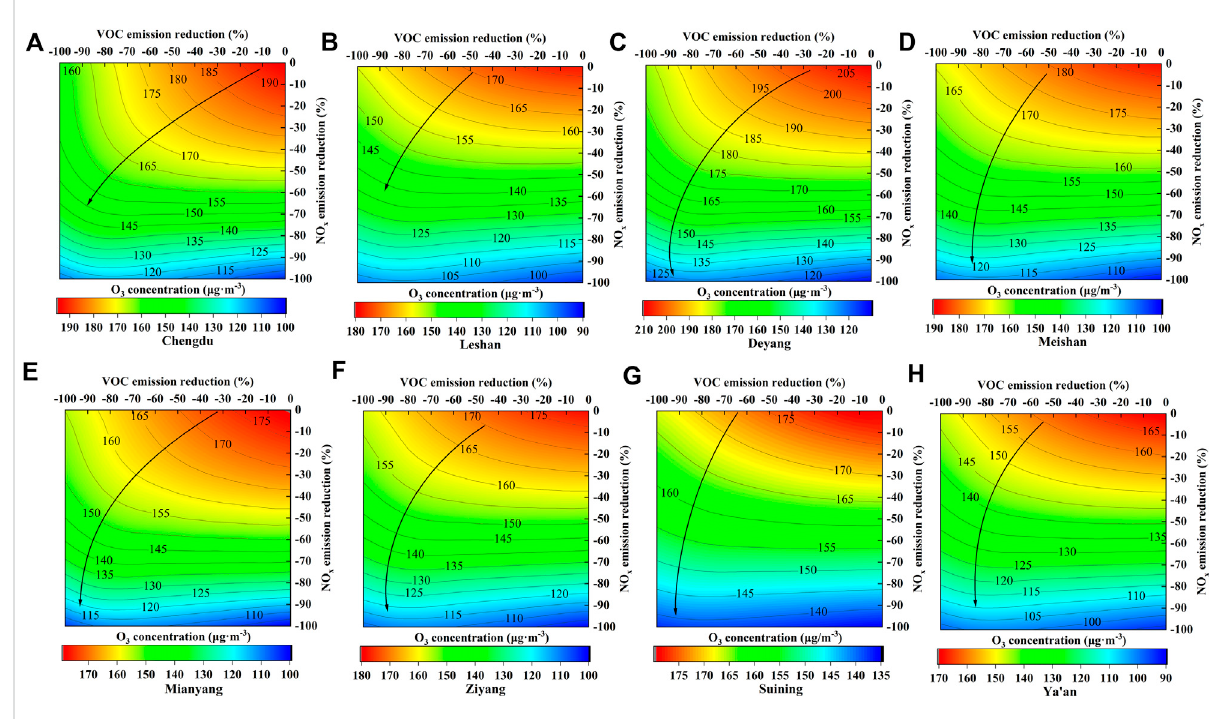
FIGURE 6 Isopleth diagrams of MDA8 O 3 varing with VOCs and NO x emission reductions for the Sichuan Province scenario ( (A) Chengdu, (B) Leshan, (C) Deyang, (D) Meishan, (E) Mianyang, (F) Ziyang, (G) Suining, (H) Ya ’ an; the black lines with arrows are